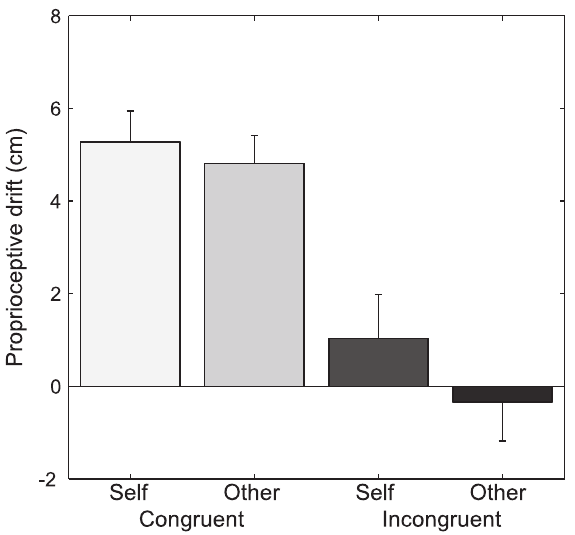
Figure 3. Proprioceptive drift. Values show mean ( + SEM) proprio- ceptive drift in centimeters. Congruent/incongruent refers to position- ing of the artificial hand relative to the participants hand, self/other refer to the mode of